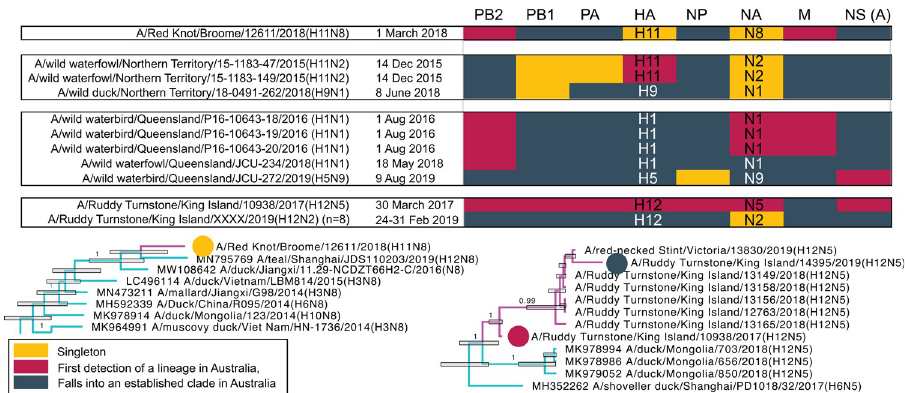
Fig 5. Viruses sequenced in this study that have signatures of recent introduction. For each segment, coloured tiles correspond to three different statuses: singletons, first detections and well-established lineages. Singletons represent the only detections of the lineage in Australia. In cases where two viruses from the same sampling effort were identical and were the only detections of that lineage, they were still considered a singleton (e.g. the NA segment of the NT/2015 viruses or the NA segment of the 8 H12N2 Ruddy Turnstone viruses from 2019, which have only ever been detected during that sampling event). Only the A allele NS segment was detected in these viruses. Phylogenetic examples (here excerpts from N8 and N5) are provided for each status, and branches are coloured as in Fig